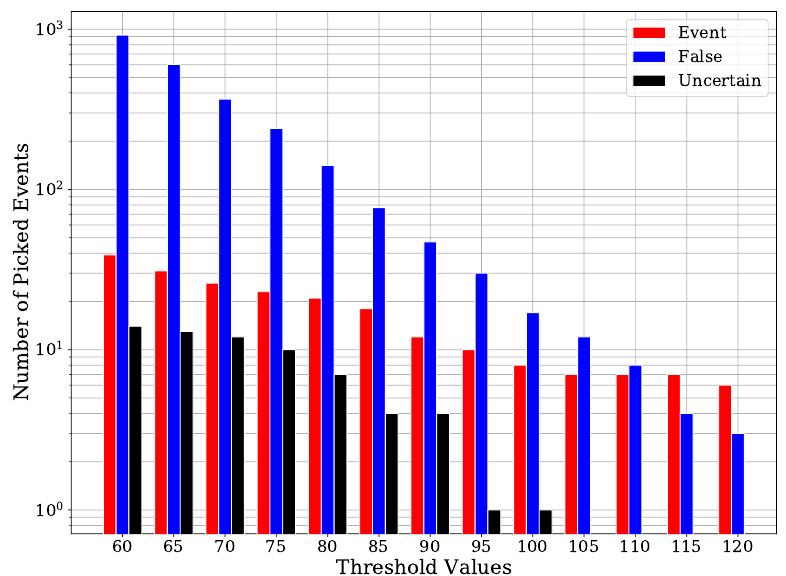
Figure 9. A barplot of STA/LTA detections with their classification at different threshold values. Using low threshold values STA/LTA picks numerous false detections, while stricter threshold values result in missing lots of true events.